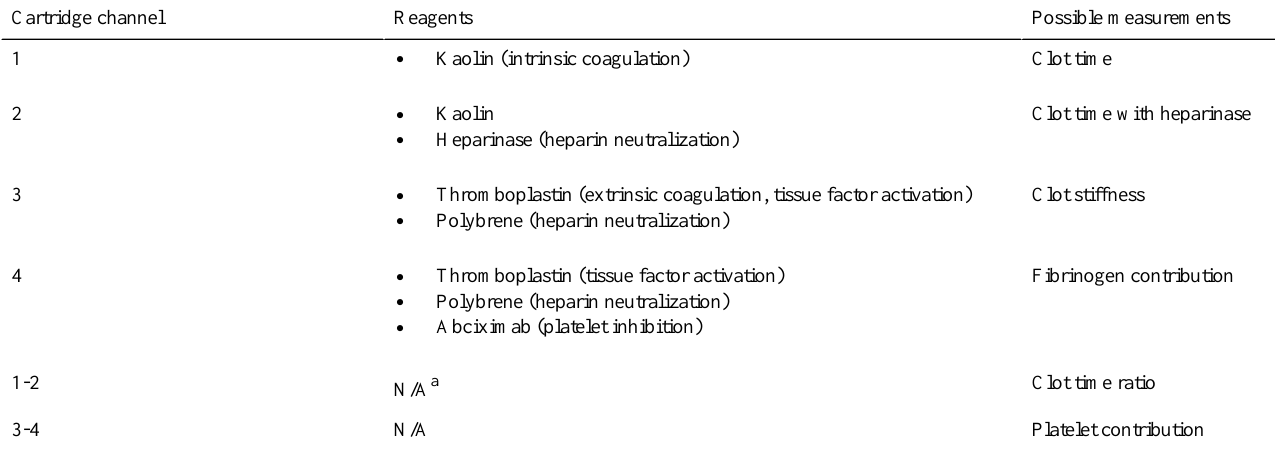
Table 1. Design and assignment of the individual channels of the measuring cartridge.